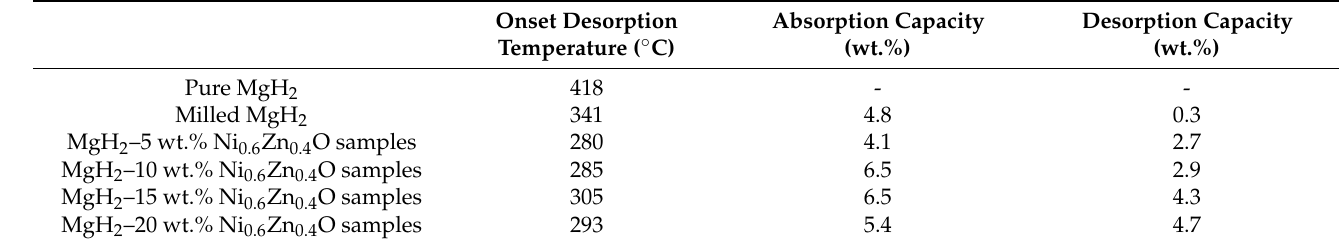
Table 3. Onset desorption temperature, absorption capacity at 250 ◦ C for 5 min and desorption capacity at 300 ◦ C for 1 h.